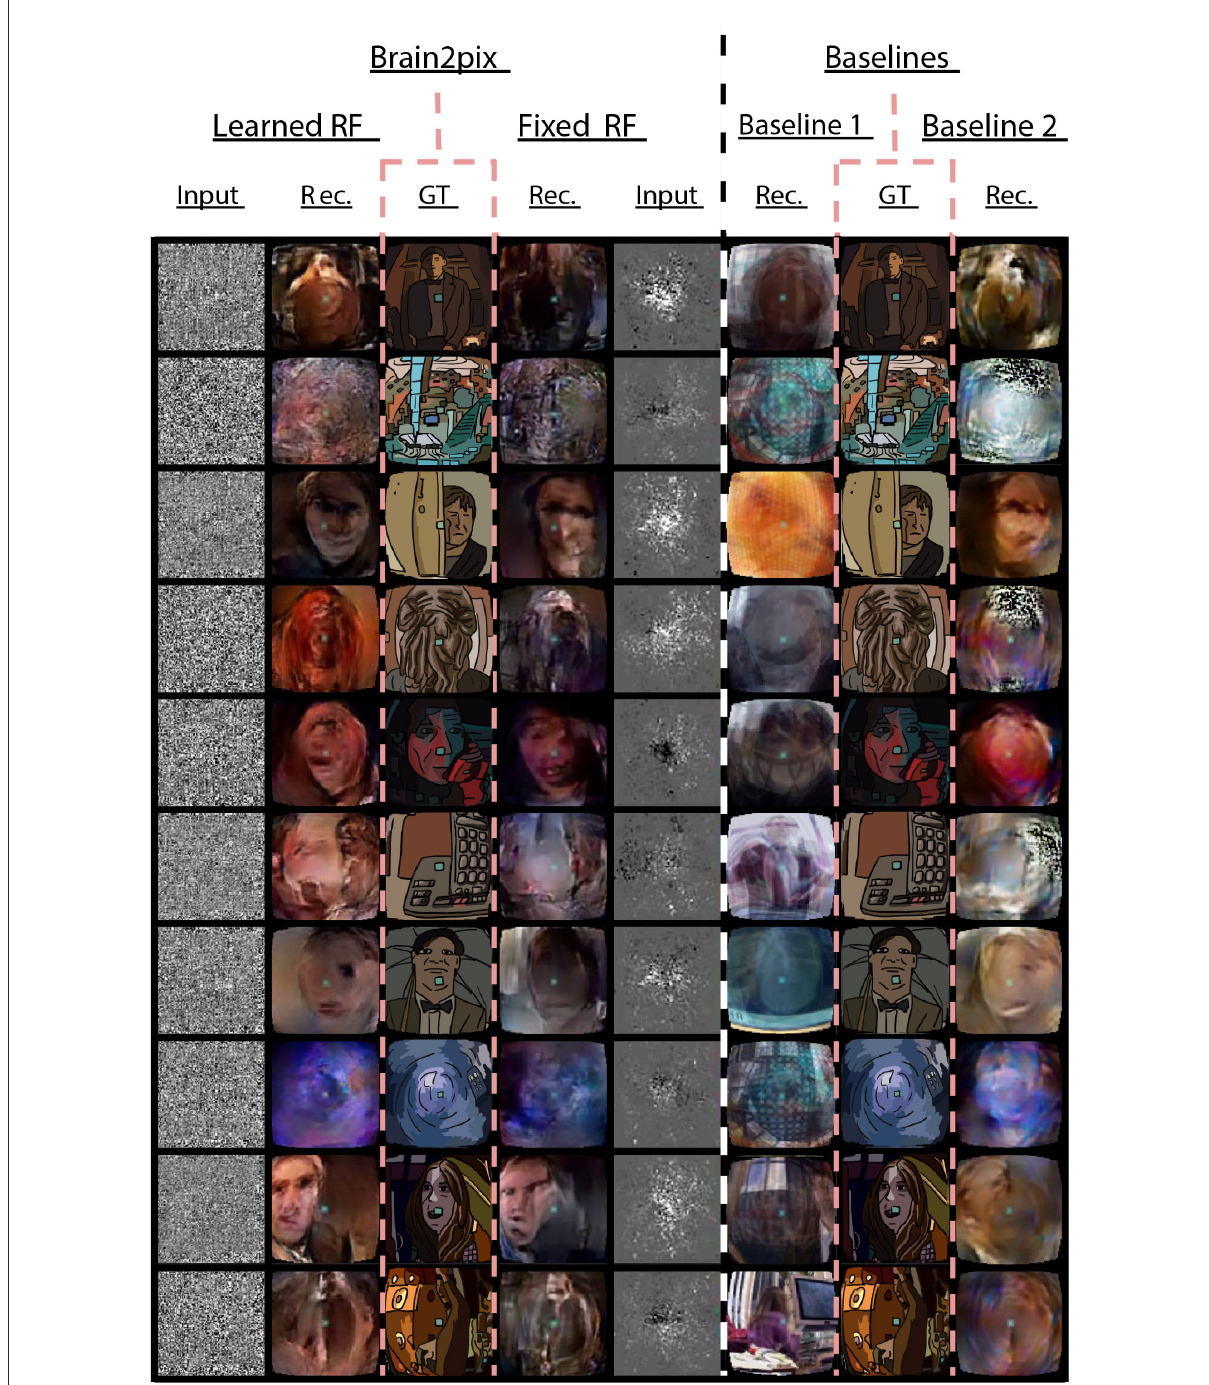
FIGURE4 Baseline experiment. Comparison between the reconstructions of the brain2pix and the baseline models. The reconstructions of brain2pix are shown in columns 2 and 4, with their corresponding ground truth (GT) in the middle column 3, and inputs in columns 1 and 5. The reconstruction of the baseline models are shown in columns 6 and 8 together with their corresponding GT in the middle column